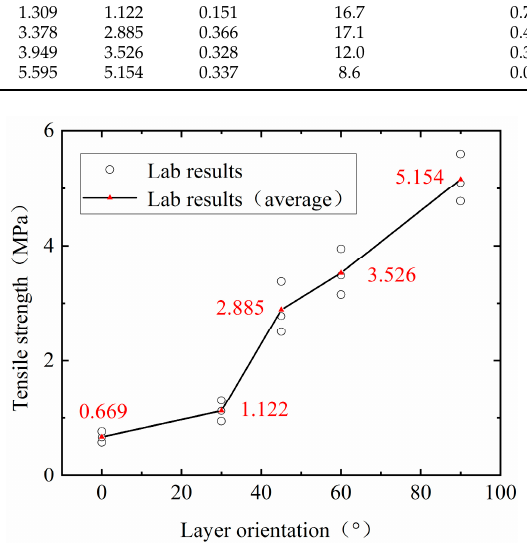
Figure 6. Tensile strength of samples with different layer orientations.